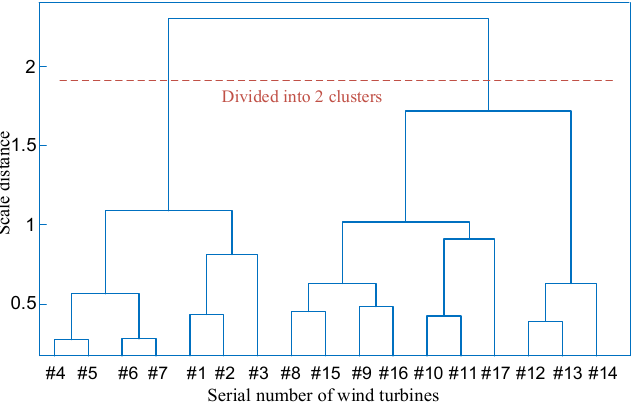
Figure 6. Hierarchical pedigree diagram of wind turbines clustering process. Inertia weight coefficient w = 0.7 and the parameters o 1 = 0.2, o 2 = 0.3 in DPSO algorithm are taken to calculate the optimal zoning result. Meanwhile, DBSCAN zoning method is compared with DPSO method and respective result is shown in Figure 7 (Wind turbines with the same symbol are in the same wind zone in Figure 7b–d). Although DBSCAN as a classical clustering algorithm can automatically determine zoning number, the output zoning results are different when input parameters such as cluster density threshold d are set to different values. In this paper, two DBSCAN results when zoning number is 2 are selected and presented. As can be seen from Figure 7, under different d values, #8, #9, #10, #15, #16, and #17 wind turbines (the serial number of wind turbines is shown in Figure 4) are divided into completely different zone, indicating that the final zoning result of DBSCAN is very sensitive to parameter selection.